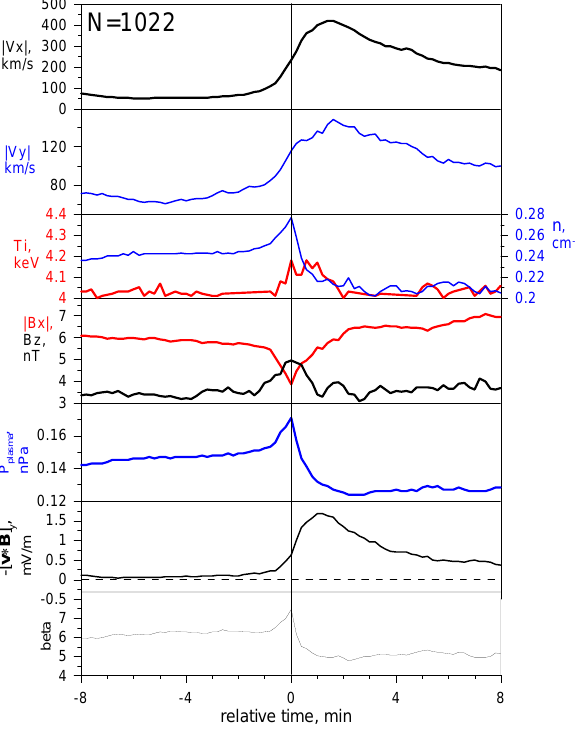
Figure 6 The same as in Fig. 5 for events with |Vx|>400 Fig. 6. The same as in Fig. 5 for events with | V x | >